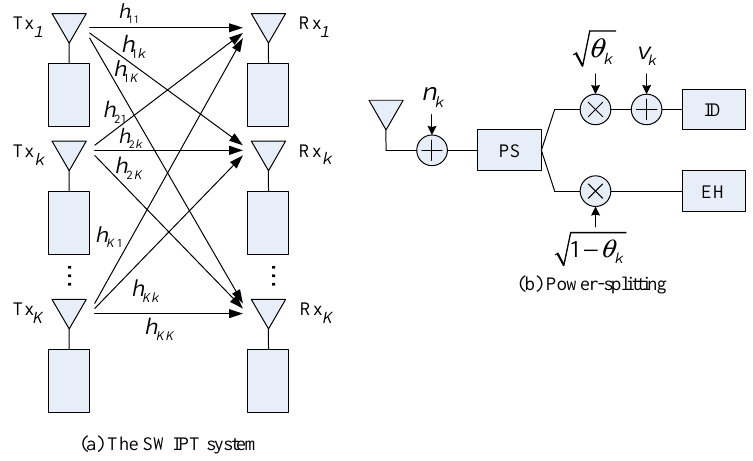
Figure 1. The SWIPT system model with a PS